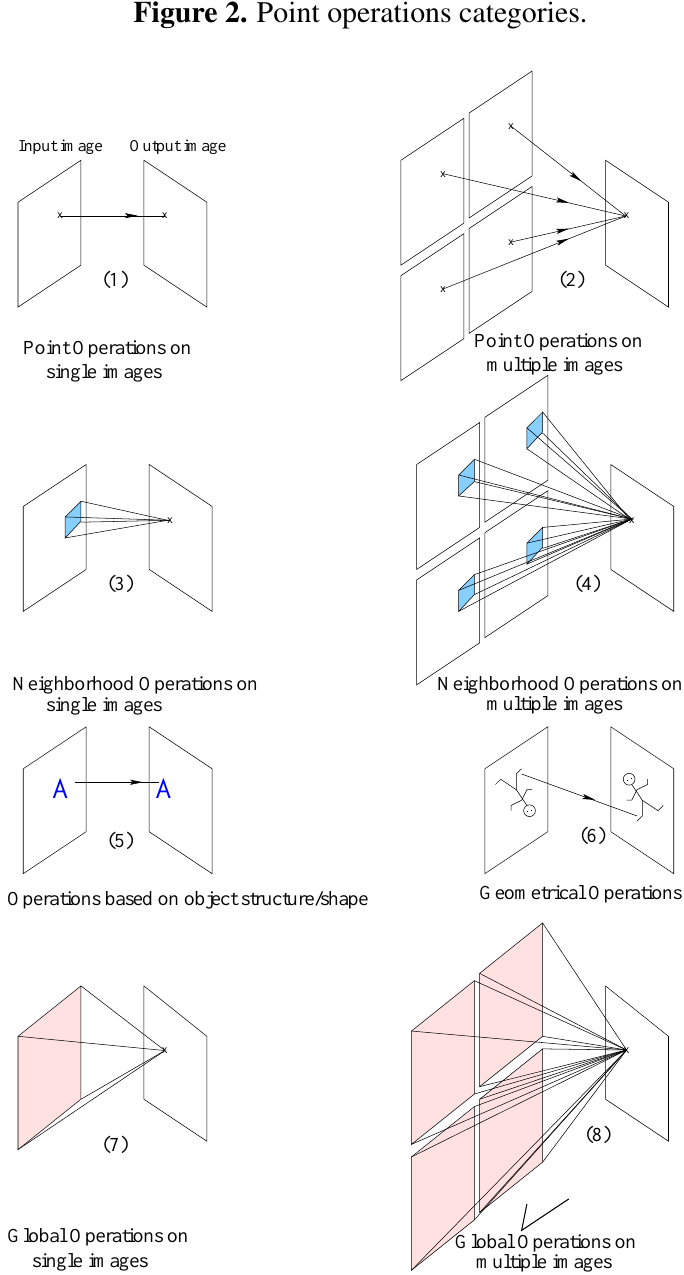
Figure 2. Point operations